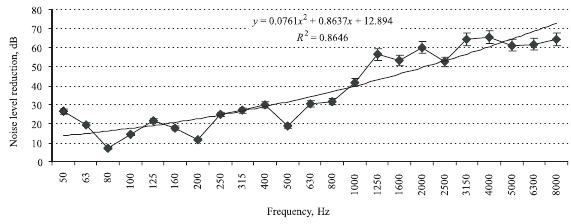
Fig. 6. Noise level reduction in the sample of experimental structure No 1 (Table